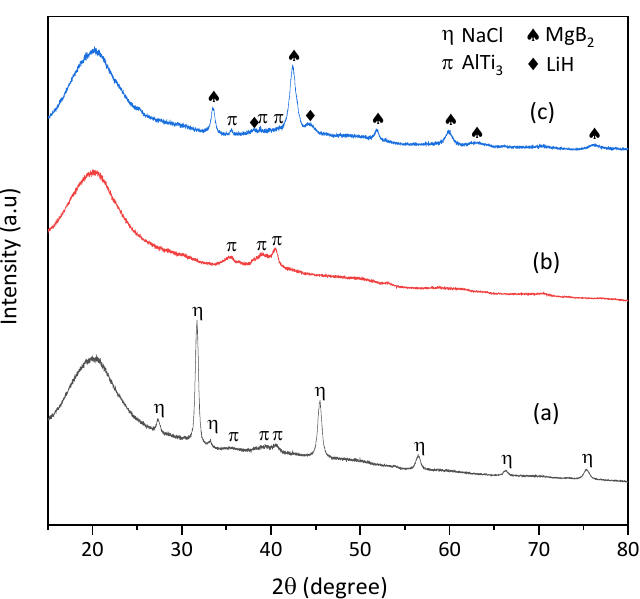
Figure 1. XRD patterns of the composites: ( a ) mixture of NaH + 3TiCl 3 ∙AlCl 3 after milling; ( b ) mixture of NaH + 3TiCl 3 ∙AlCl 3 after washing and drying; and ( c ) the Li-RHC + AlTi 3 sample after milling.